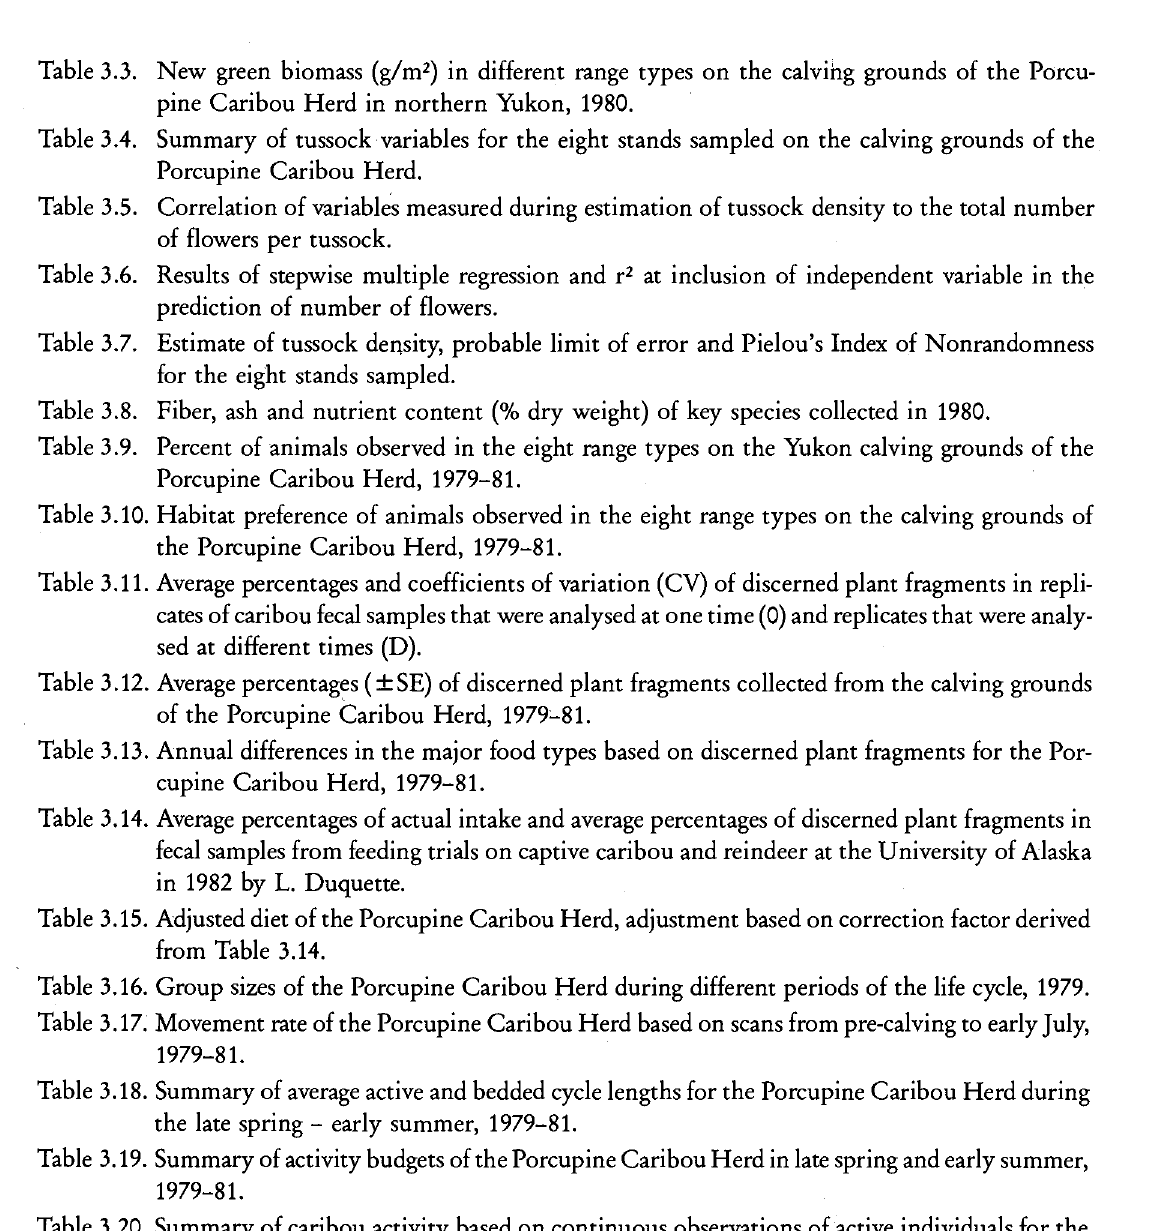
Table 3.3. New green biomass (g/m 2 ) in different range types on the calving grounds of the Porcu pine Caribou Herd in northern Yukon, 1980. Table 3.4. Summary of tussock variables for the eight stands sampled on the calving grounds of the Porcupine Caribou Herd. Table 3.5. Correlation of variables measured during estimation of tussock density to the total number of flowers per tussock. Table 3.6. Results of stepwise multiple regression and r 2 at inclusion of independent variable in the prediction of number of flowers. Table 3.7. Estimate of tussock density, probable limit of error and Pielou's Index of Nonrandomness for the eight stands sampled. Table 3.8. Fiber, ash and nutrient content (% dry weight) of key species collected in 1980. Table 3.9. Percent of animals observed in the eight range types on the Yukon calving grounds of the Porcupine Caribou Herd, 1979-81. Table 3.10. Habitat preference of animals observed in the eight range types on the calving grounds of the Porcupine Caribou Herd, 1979-81. Table 3.11. Average percentages and coefficients of variation (CV) of discerned plant fragments in repli cates of caribou fecal samples that were analysed at one time (0) and replicates that were analy sed at different times (D). Table 3.12. Average percentages (±SE) of discerned plant fragments collected from the calving grounds of the Porcupine Caribou Herd, 1979-81. Table 3.13. Annual differences in the major food types based on discerned plant fragments for the Por cupine Caribou Herd, 1979-81. Table 3.14. Average percentages of actual intake and average percentages of discerned plant fragments in fecal samples from feeding trials on captive caribou and reindeer at the University of Alaska in 1982 by L. Duquette. Table 3.15. Adjusted diet of the Porcupine Caribou Herd, adjustment based on correction factor derived from Table 3.14. Table 3.16. Group sizes of the Porcupine Caribou Herd during different periods of the life cycle, 1979. Table 3.17. Movement rate of the Porcupine Caribou Herd based on scans from pre-calving to early July, 1979-81. Table 3.18. Summary of average active and bedded cycle lengths for the Porcupine Caribou Herd during the late spring - early summer, 1979-81. Table 3.19. Summary of activity budgets of the Porcupine Caribou Herd in late spring and early summer, 1979-81. Table 3.20. Summary of caribou activity based on continuous observations of active individuals for the Porcupine Caribou Herd, late spring to early summer, 1978-83. Table 3.21. Frequency of complete active cycles for calves and adults for the Porcupine Caribou Herd, late spring - early summer, 1978-83. Table 3.22. Frequency of complete bedded cycles for calves and adults for the Porcupine Caribou Herd, late spring - early summer, 1978-83. Table 3.23. Frequency and duration of nursing bouts for calves of the Porcupine Caribou Herd, late spring - early summer, 1979-81. Table 3.24. Size and rate of movement (km/h) of bands of male caribou in northern Yukon in 1983. Table 3.25. Daily activity budgets (% time ± estimated 95% confidence intervals) for. male caribou in northern Yukon in